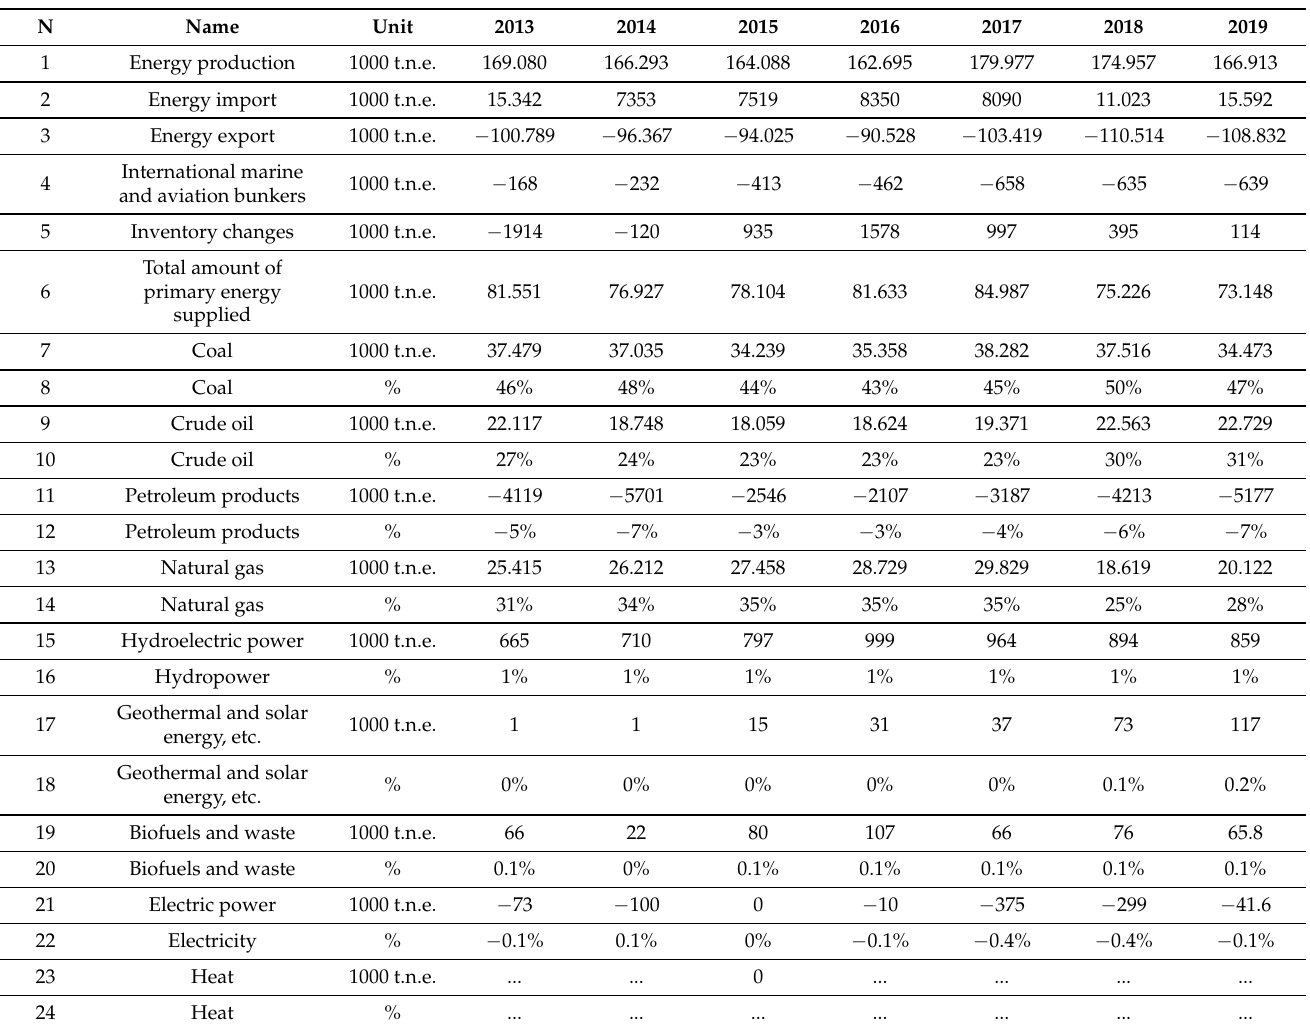
Table 3. Total amount of primary energy supplied by the Republic of Kazakhstan for 2013–2019. Note: developed by the authors (Bureau of National Statistics of the Agency for Strategic Planning and Reforms of the Republic of Kazakhstan,